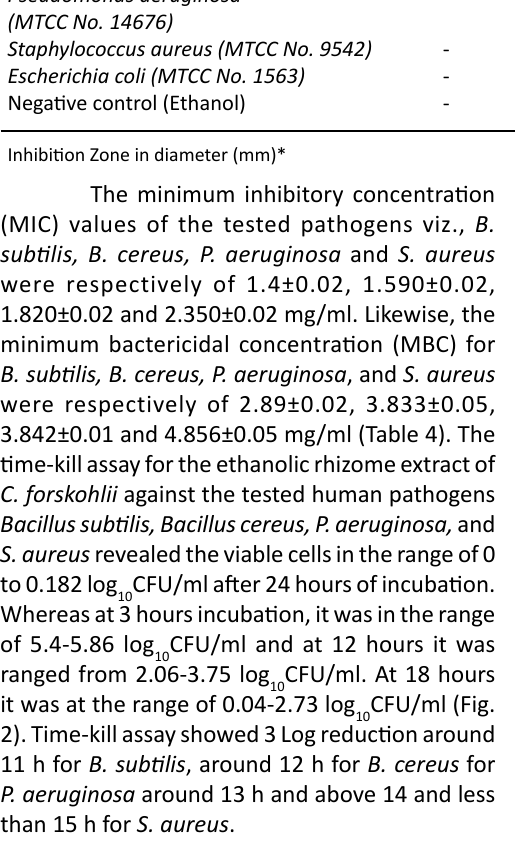
Concentrations of ethanolic rhizome extract used